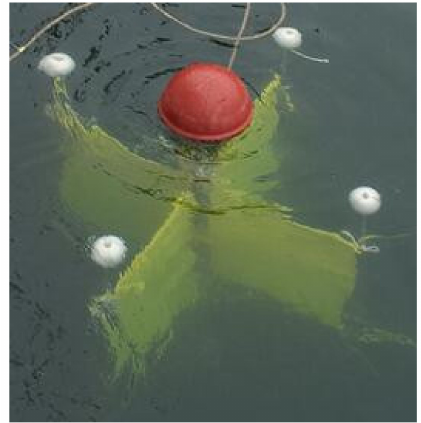
Figure 2. A drifting buoy at work. The GOCI is a satellite sensor with the observation center of (130 ◦ E, 36 ◦ N). The GOCI observations are imaged eight times per day with 2500 km × 2500 km coverage and 500-m resolution; and there are eight bands: six visible bands centered around 412, 443, 490, 555, 660, and 680 nm, and two near-infrared (NIR) bands at wavelengths of 745 and 865 nm. The original observation times of the drifting buoy are inconsistent with the imaging times of the GOCI. To match the GOCI data, the spatiotemporal information carried by each drifting buoy needs to be resampled and standardized. The imaging count of GOCI is eight times a day (from 8:30 to 15:30 Beijing time), so we selected the moment closest to the imaging time to perform interpolation processing on buoy data. Then, the obtained latitude and longitude of the buoy were used to acquire the bio-optical properties from GOCI products for the water parcel. We expanded the drifter’s dataset by adding the ocean color products retrieved from the GOCI, including remote sensing reflectance and inherent optical properties. The GOCI data are collected according to the drifter’s sampling